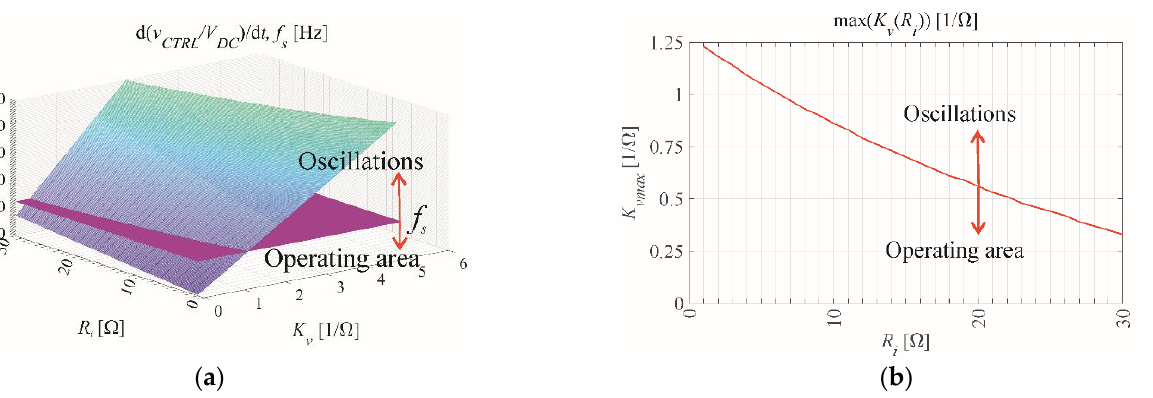
Figure 10. The relationship between maximum voltage gain K v and current gain R i for the assigned VSI parameters f s = 25,600 Hz, L F = 2 mH, C F = 51 μF, and R LFe = 1 Ω in ( a ) 3-D and ( b ) 2-D.